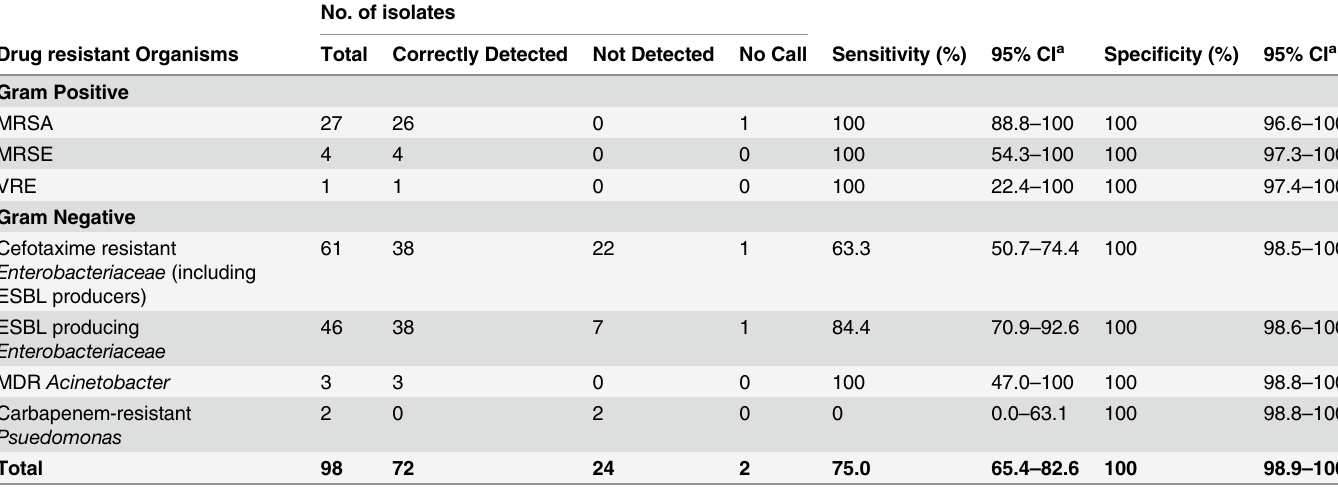
Table 5. Performance of Verigene Test in detection of drug resistant